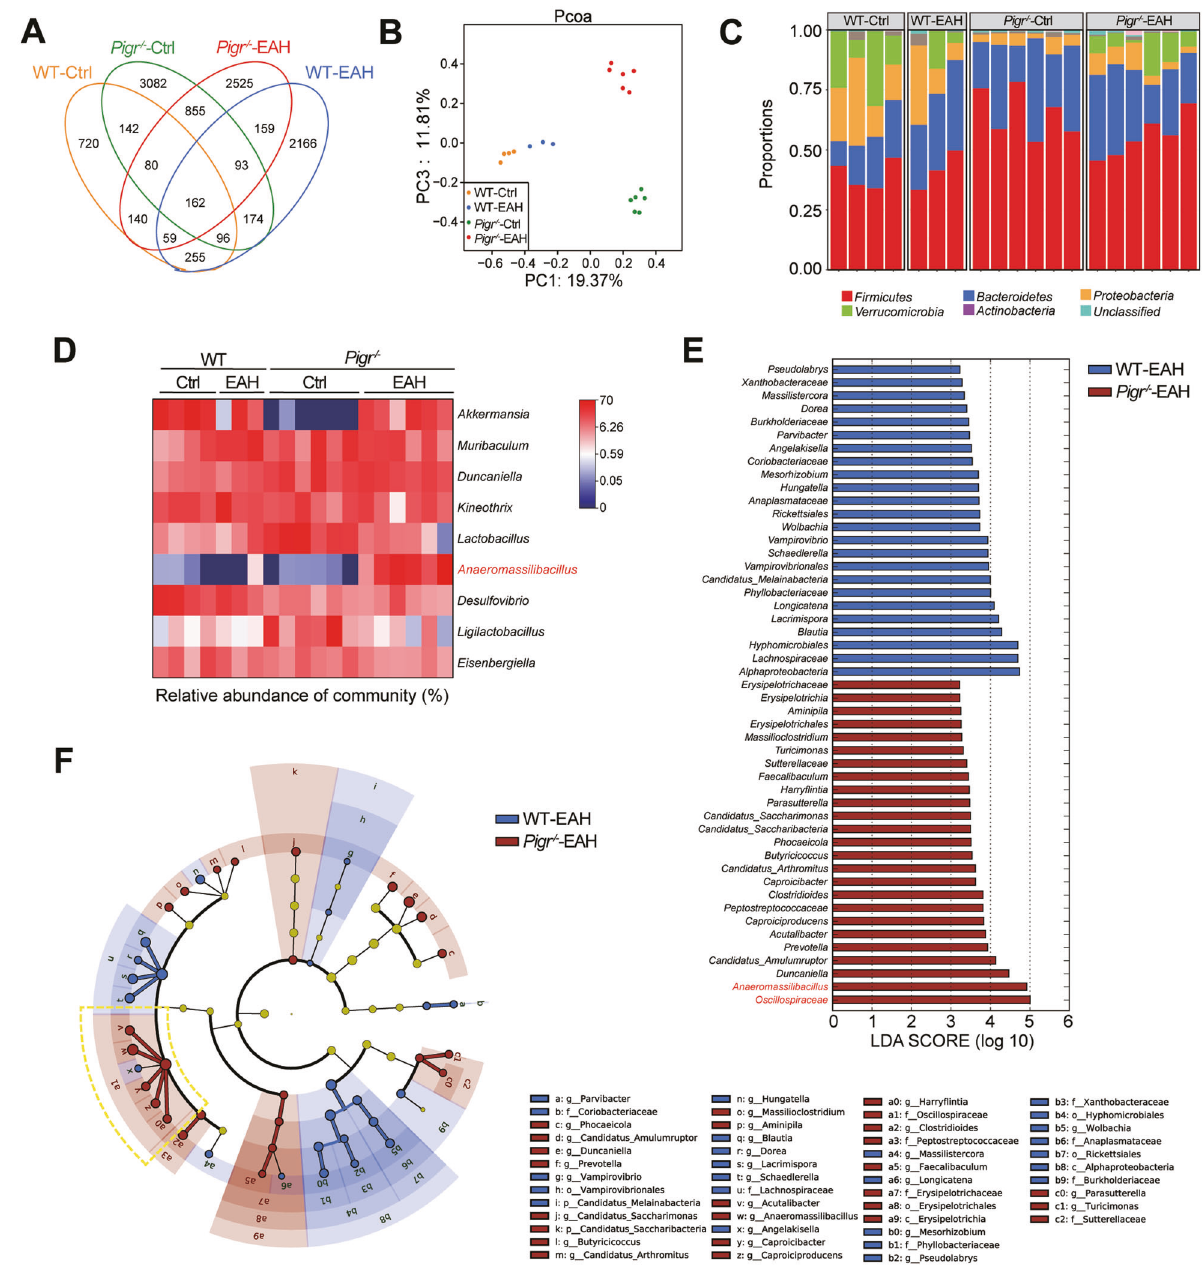
Fig. 3 Pigr − / − mice develop gut dysbiosis. A Venn diagram. B Principal component analysis of unweighted UniFrac analysis. C Relative abundance of bacteria at the phylum level. D Heatmap of bacteria at the genus level. E Linear discriminant analysis (LDA) score. F Cladogram plot of LEfSe analysis. The yellow frame indicates the 5 signi fi cantly differential genus in Oscillospiraceae